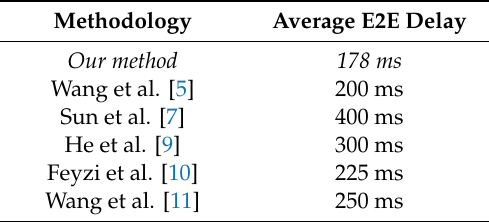
Table 4. E2E delay